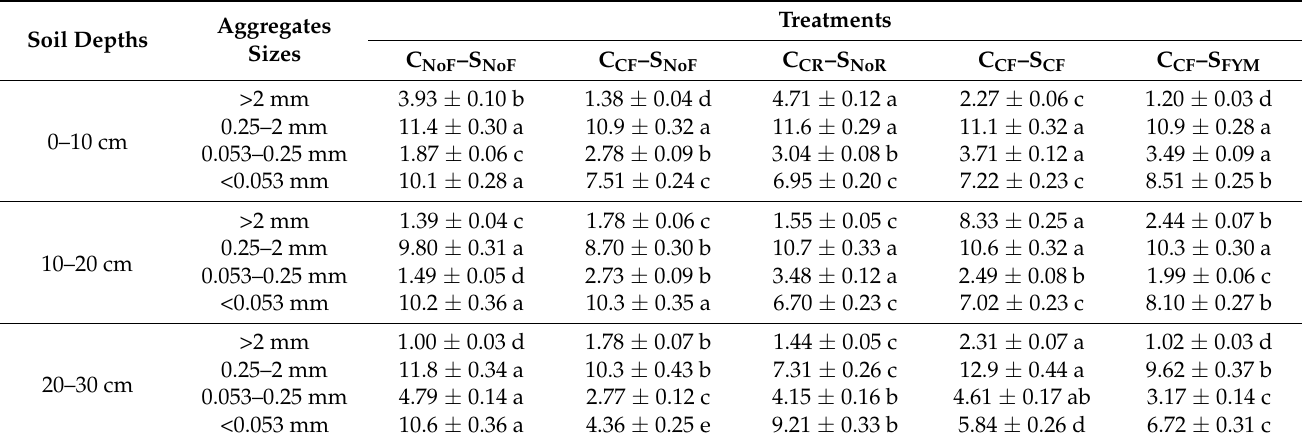
Table 5. SOC storage (t hm − 2 ) within soil